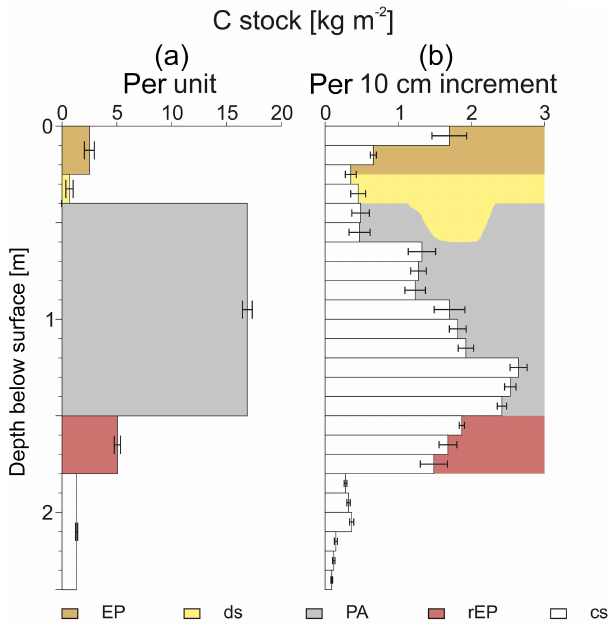
Figure 5. C org stocks of the profile R 2014 , calculated (a) for each unit and (b) per 10cm depth